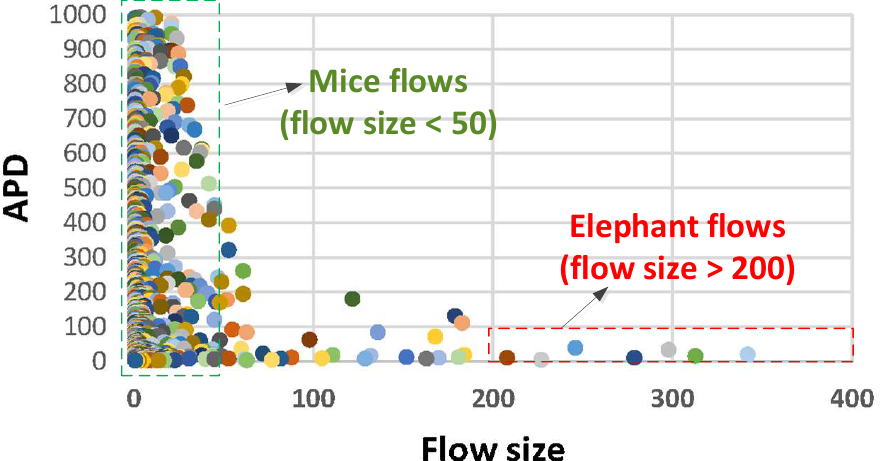
Figure 6. Evaluation results of package distances of flows in real-world